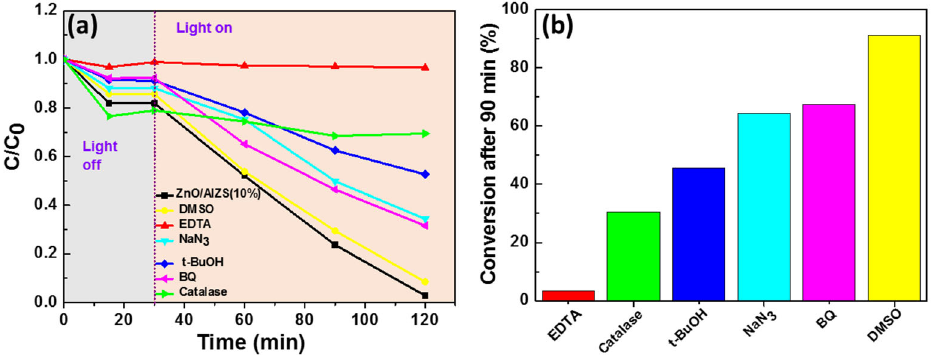
Figure 8. ( a ) Photodegradation of AO7 using the ZnO/AIZS(10) catalyst in the presence of scavengers and ( b ) percentage of AO7 degradation after 90 min of visible light irradiation.